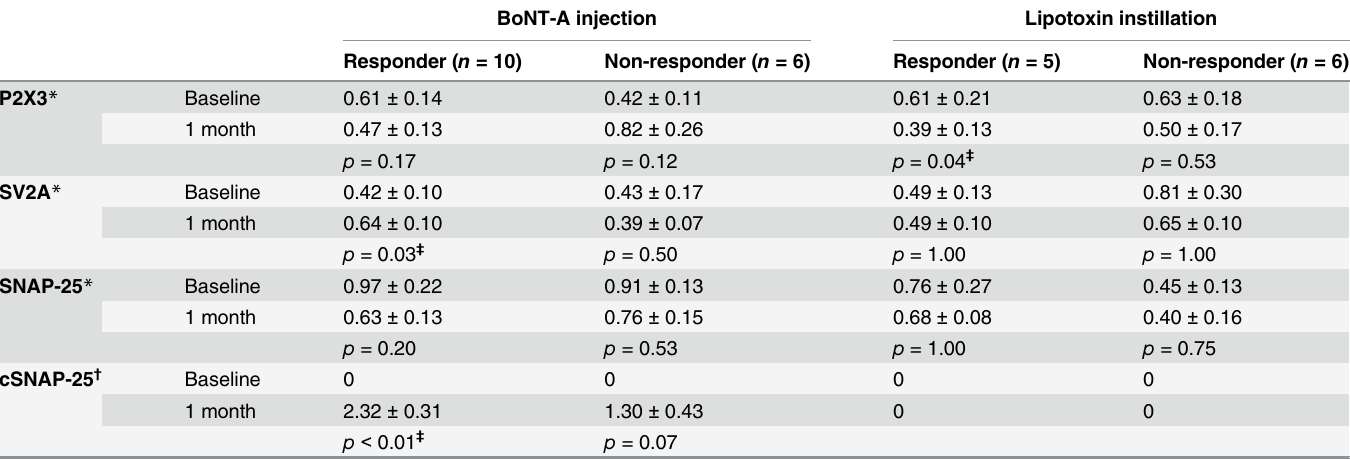
Table 3. Changes inP2X3, SV2A, SNAP-25, and cSNAP-25 expressions between responders and non-responders to BoNT-A injection or Lipotoxin instillation at baseline and one month after treatment. BoNT-A